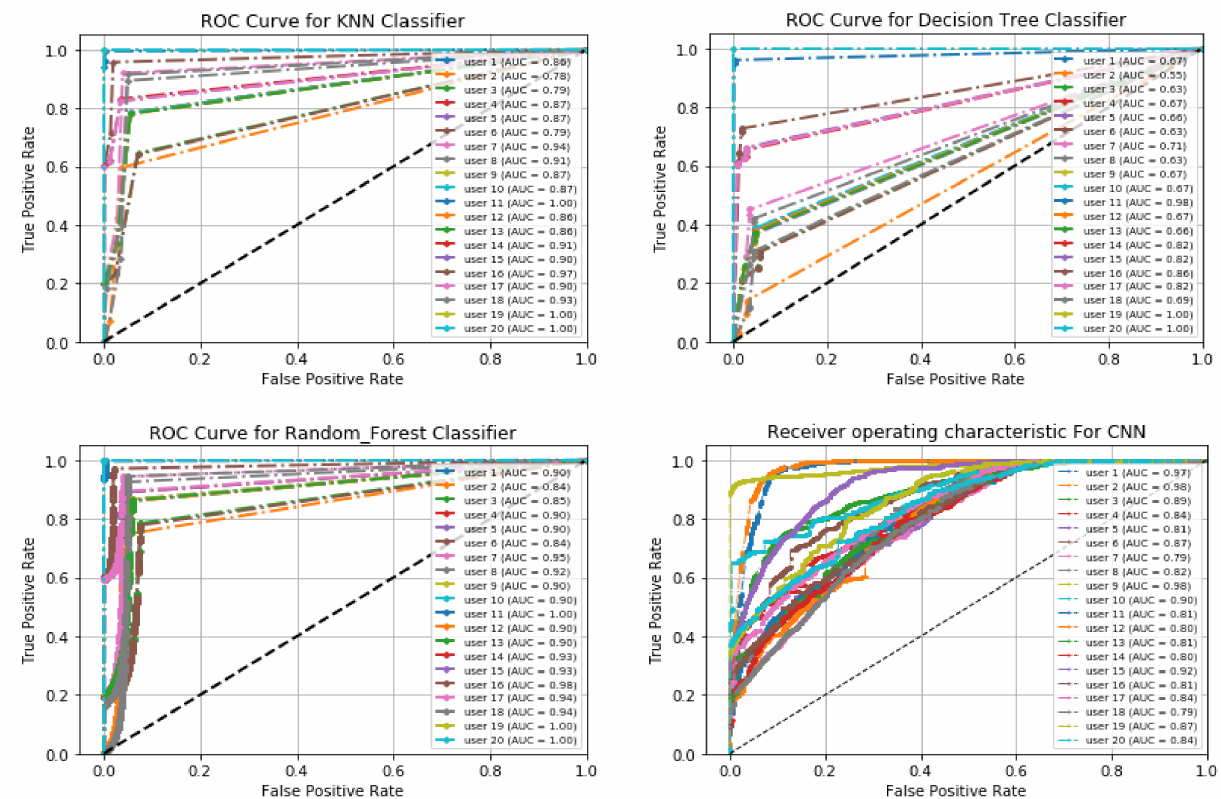
Figure 17. ROC curves for anomaly detection—set of mouse movement and point-and-click